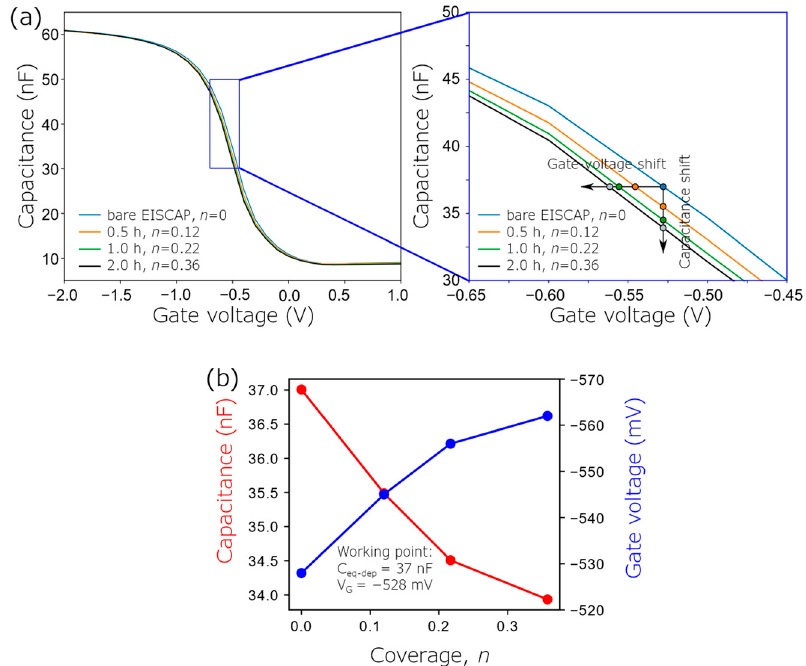
Figure 5. ( a ) Measured C – V curves of a bare EISCAP and an EISCAP decorated with positively charged AOT-AuNPs of different coverages n (for different times of immobilization between 0.5 and 2 h) with a zoomed graph of the depletion region. ( b ) Capacitance changes (at a constant gate voltage of − 528 mV) and gate voltage shifts (at a constant capacitance of 37 nF) evaluated from the C – V curves as a function of the AuNP coverage.